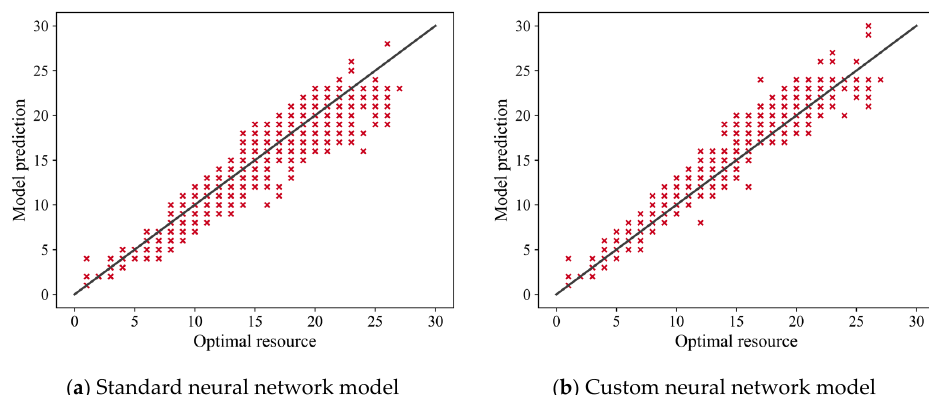
Figure 6. Optimal resources versus prediction on the test dataset.